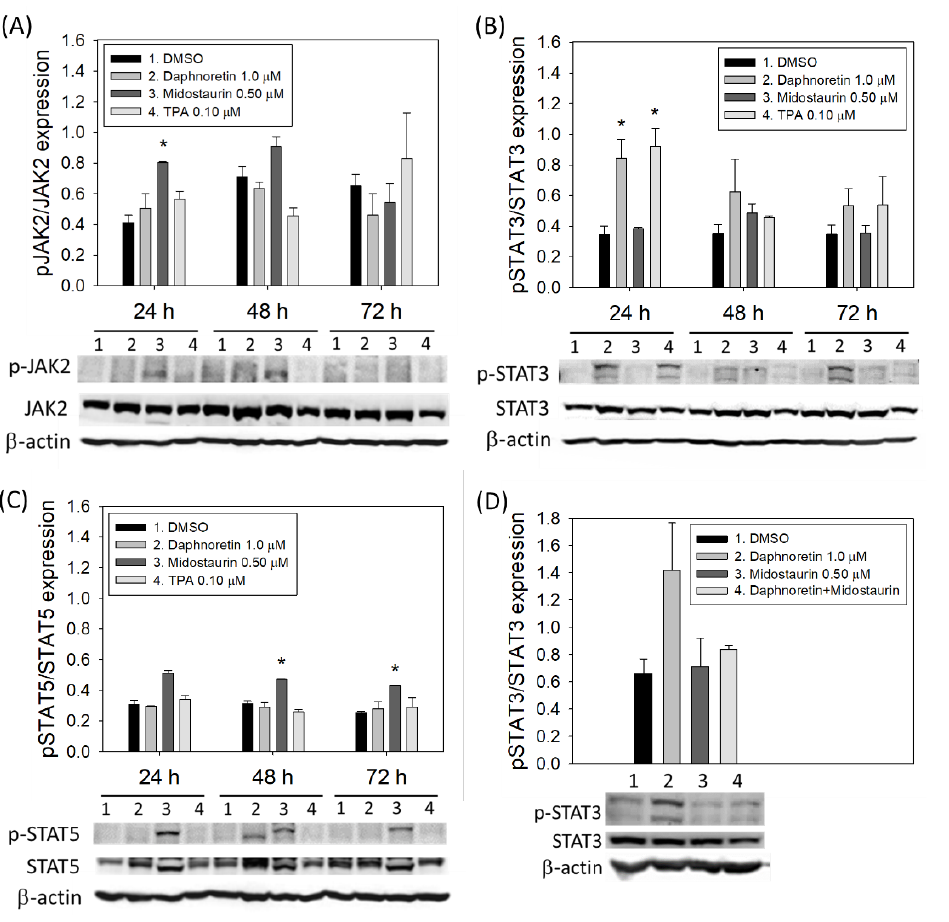
Figure 5. Immunoblot analysis of K562 cells treated with DMSO, daphnoretin (1 µ M), midostaurin (0.5 µ M), or 12-O-tetradecanoyl-phorbol-13-acetate (TPA; 0.1 µ M) for 24–72 h. Normalization of (A) JAK2, (B) STAT3, (C) STAT5, as well as (D) expression levels of STAT3 after combined daphnoretin and midostaurin, relative to levels of the internal control, β -actin. Data are presented as the mean ± SD of three independent experiments. * p < 0.05 vs. DMSO-treated sample (ANOVA test followed by Dunnett’s post-hoc test).